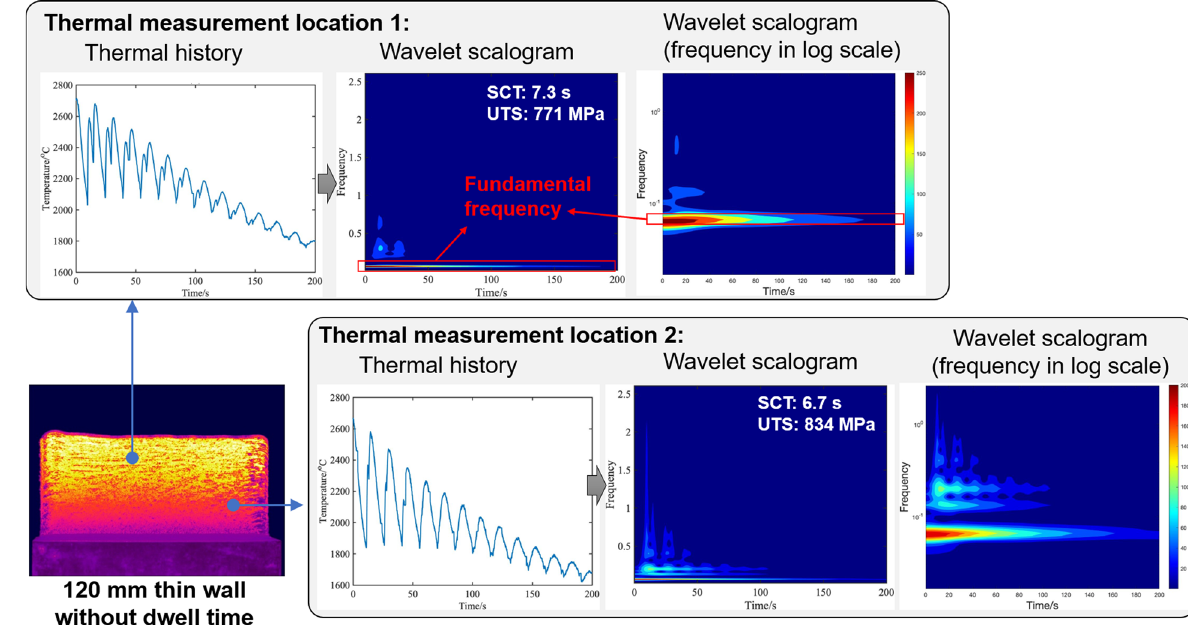
Fig. 5 Thermal histories and corresponding wavelet scalograms on the thin wall without dwell time. They are obtained at different thermal measurement locations. SCT indicates solidi fi cation cooling time and UTS indicates ultimate tensile